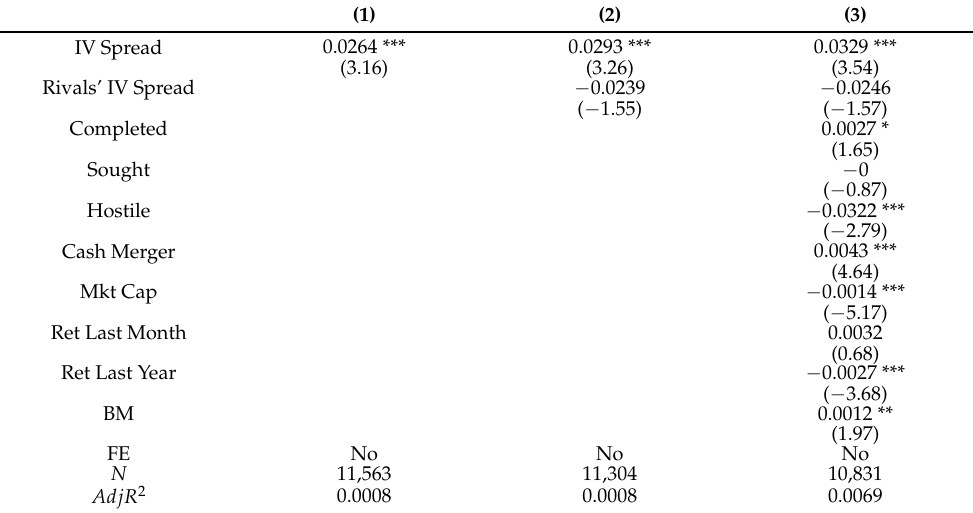
Table 9. Rival Implied Volatility Spread and Acquirer Announcement